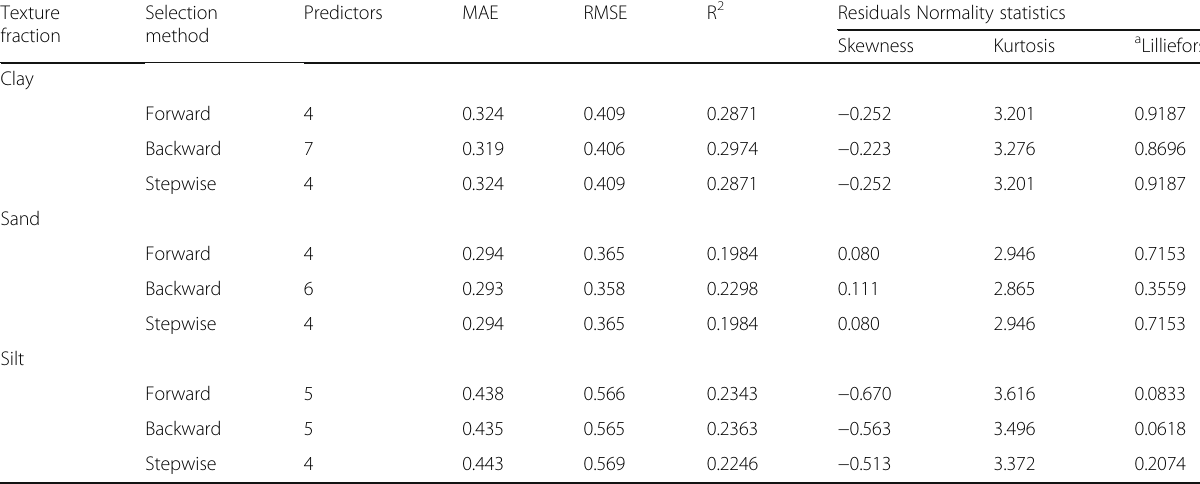
Table 3 Cross validation of models by MLR applying different predictors selection methods Texture fraction